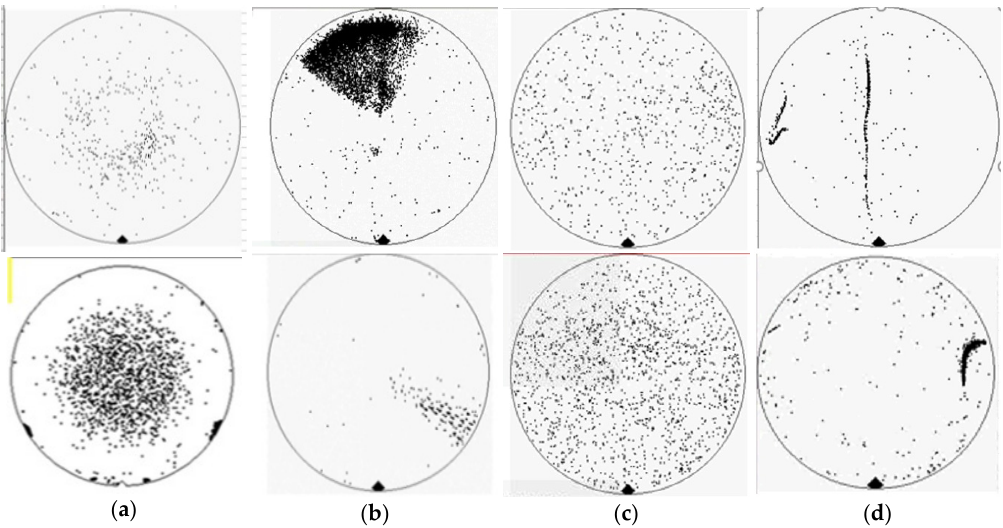
Figure 7. Examples of correctly classified images: ( a ) center, ( b ) local, ( c ) random, and ( d ) scrape .